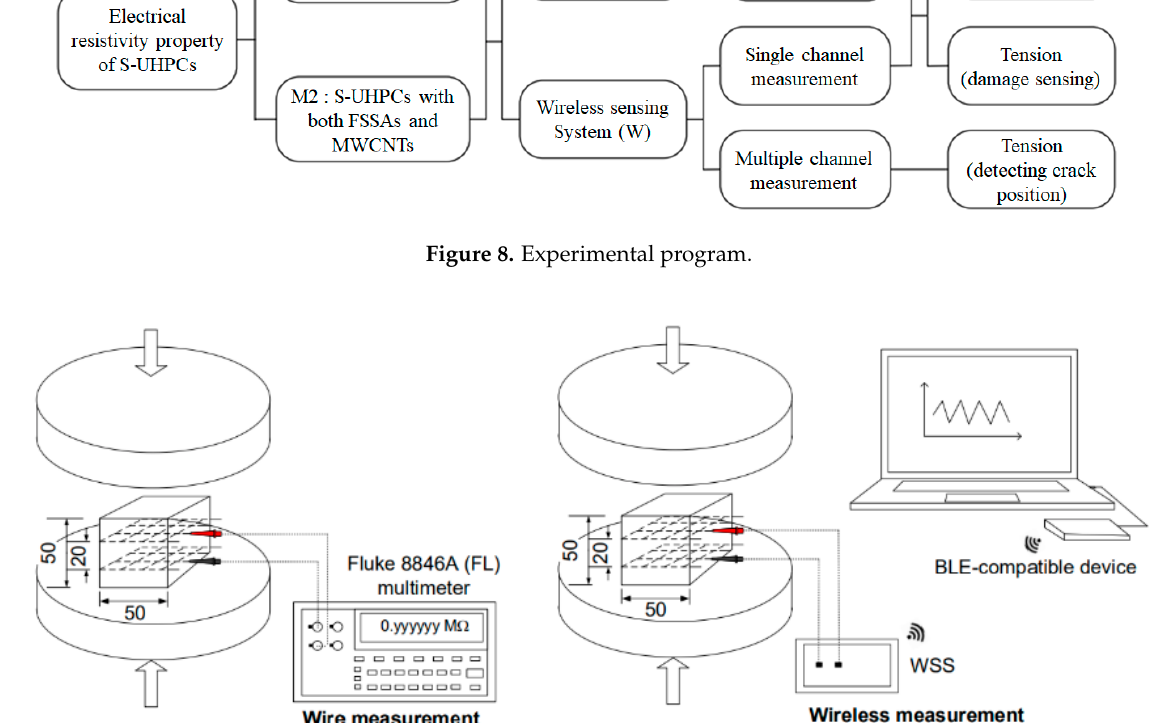
Figure 8. Experimental program.